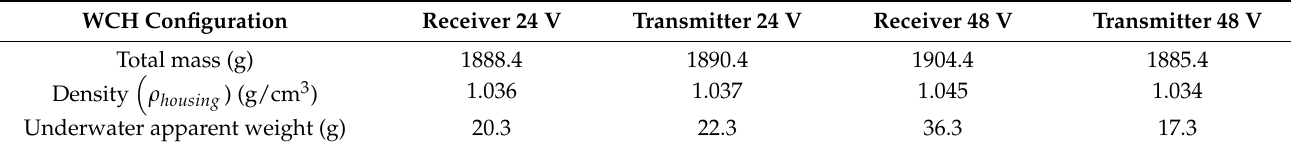
Table 9. Underwater apparent weight of the different WCH